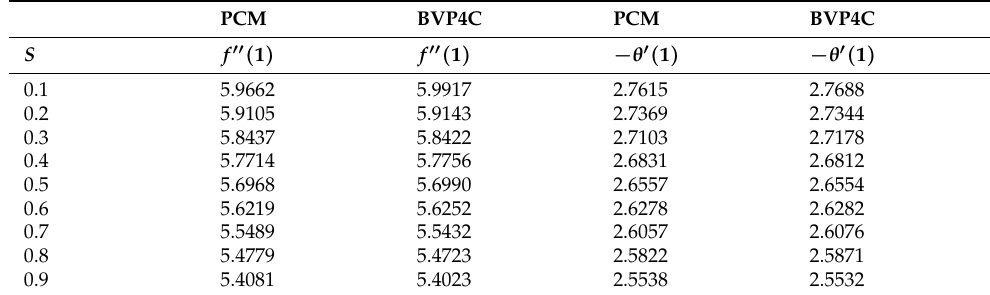
Table 3. Comparison of the numerical results by two methods PCM and BVP4C for Skin friction and Nusselt number, with various physical parameters and Φ 1 = Φ 2 = 0.1.